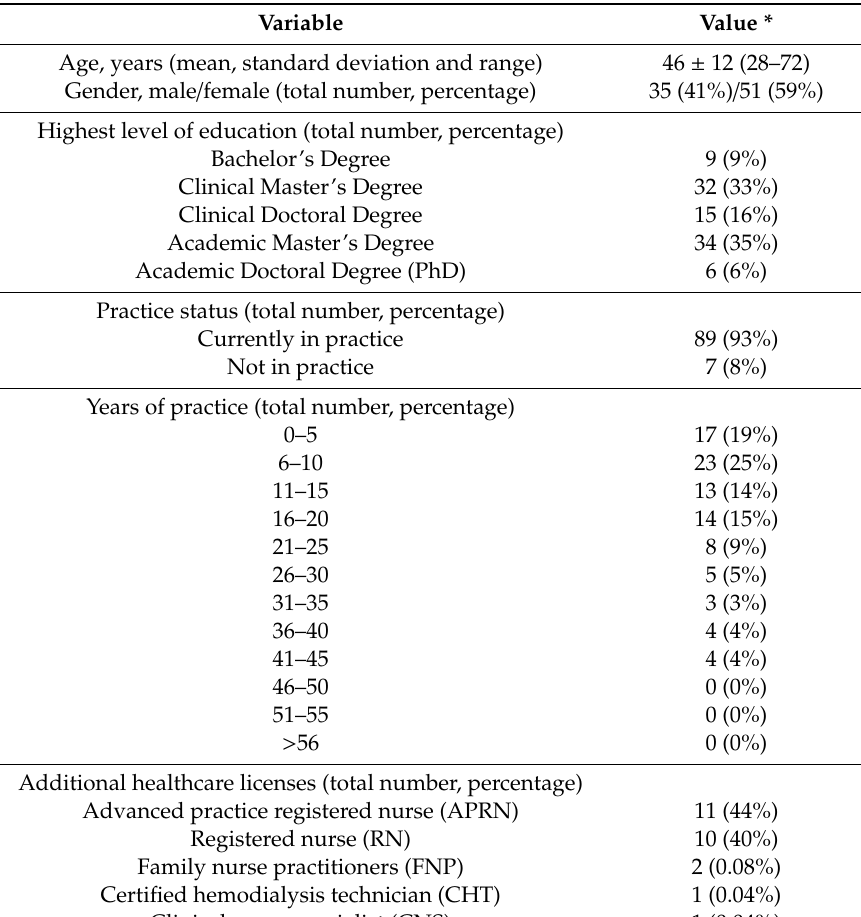
Table 1. Participants’ demographics and characteristics.